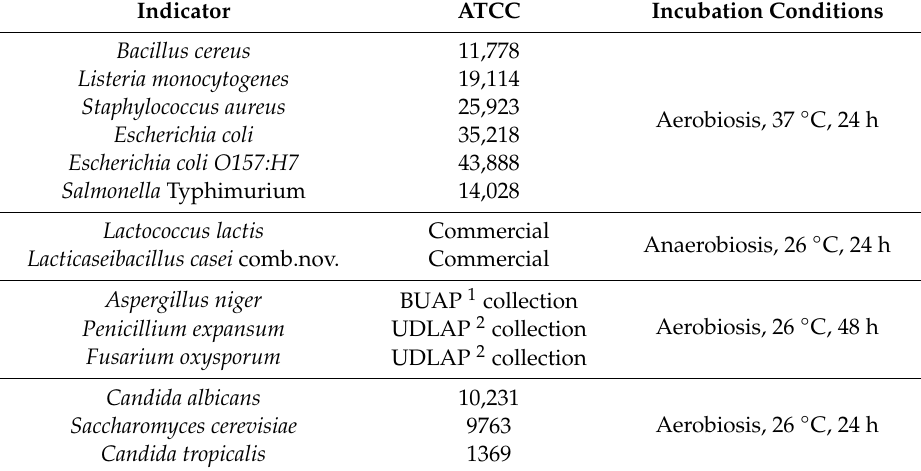
Table 1. Indicator microorganisms used for the growth response assessment in Lactic Acid Bacteria (LAB) isolates determination of antimicrobial